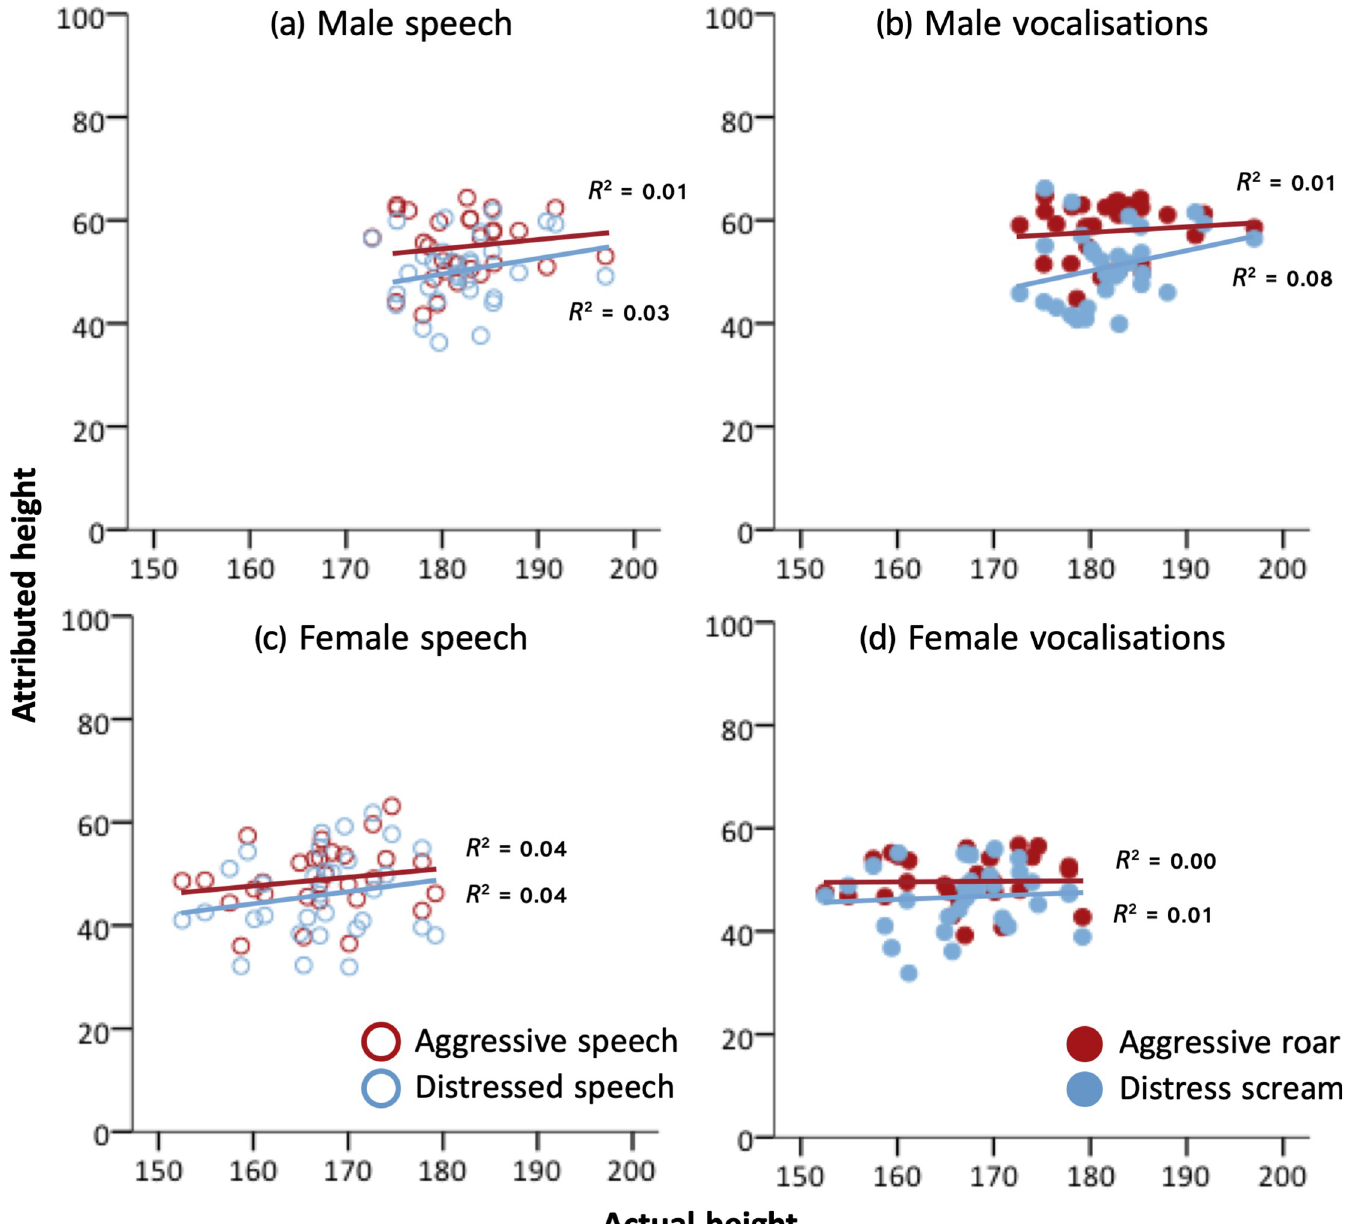
Fig 4. Attributed height as a function of actual height, when listeners rated (a) male speech stimuli, (b) male vocalizations, (c) female speech stimuli, and (d) female vocalizations. Each data point represents the mean height rating averaged across listeners attributed to each vocalization. Blue circles represent distress stimuli, red circles represent aggressive stimuli. Open circles represent speech stimuli, closed circles represent vocalizations. R 2 values for each regression line are reported in the graphs.